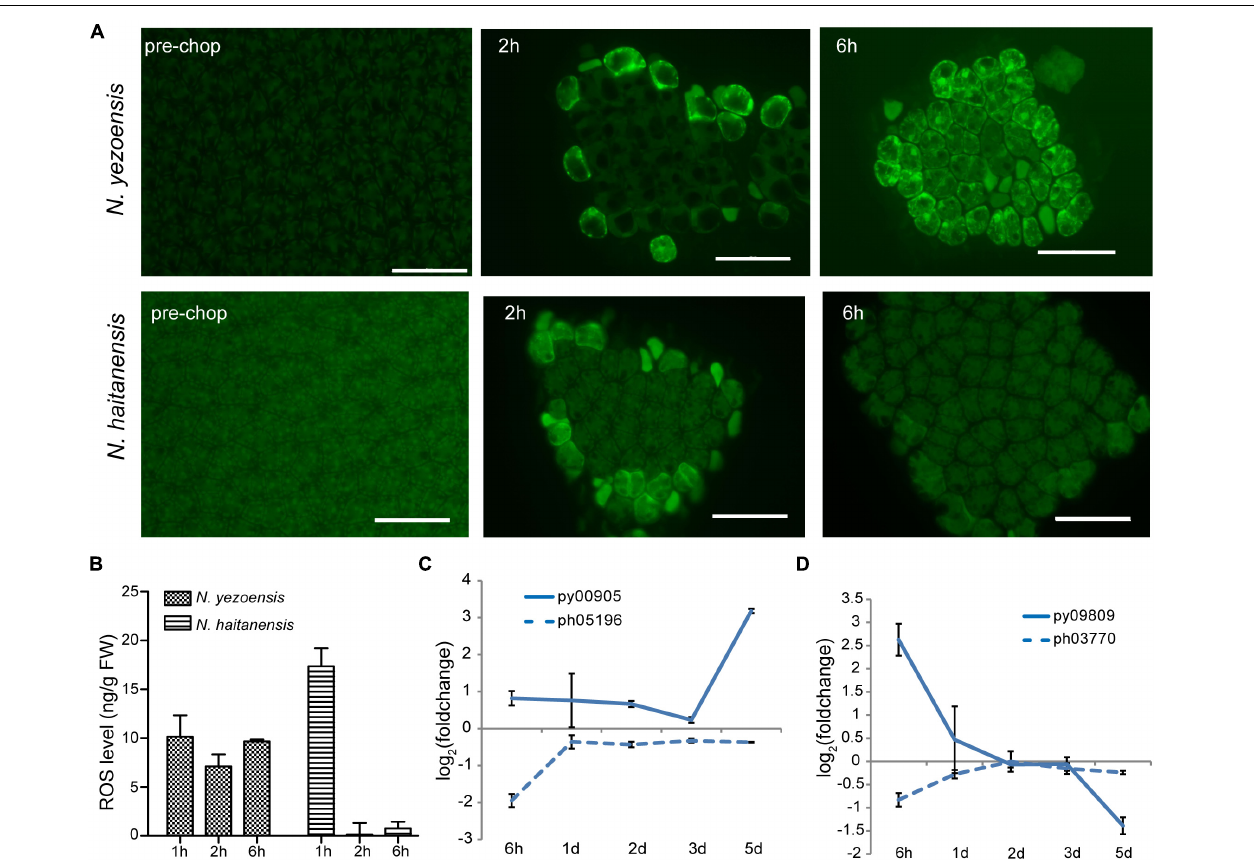
FIGURE 2 | ROS-mediated systematic signaling in N. yezoensis thallus fragments in response to wound stress. (A) ROS staining of intact thalli and fragments 2 and 6 h after wounding. Upper panel images are N. yezoensis ; lower N. haitanensis . Dark green backgrounds in each image are auto-fluorescence. Bars represent 50 µ m in each panel. (B) Total ROS detected in excised fragments in the two species. Columns and vertical bars represent the average values and SD ( n = 3). (C) Transcriptional variation of RBOH genes in Neopyropia after wounding. The log 2 value of FPKM foldchange compared to the intact sample for each time point was used for plotting. The solid line and dashed line represent genes from N. yezoensis and N. haitanensis , respectively. The same line colors indicate the two genes are best reciprocal hits. (D) Transcriptional variation of SOD genes in Pyropia after